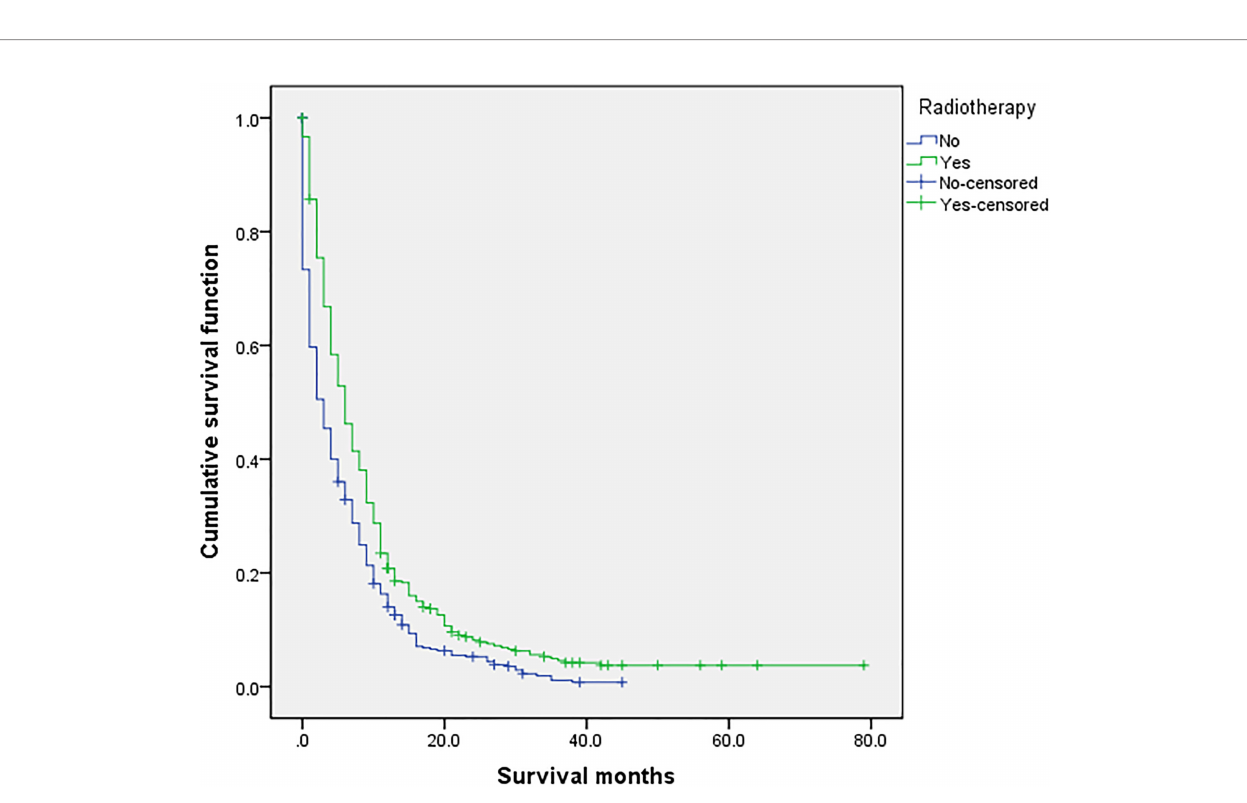
Frontiers in Oncology |